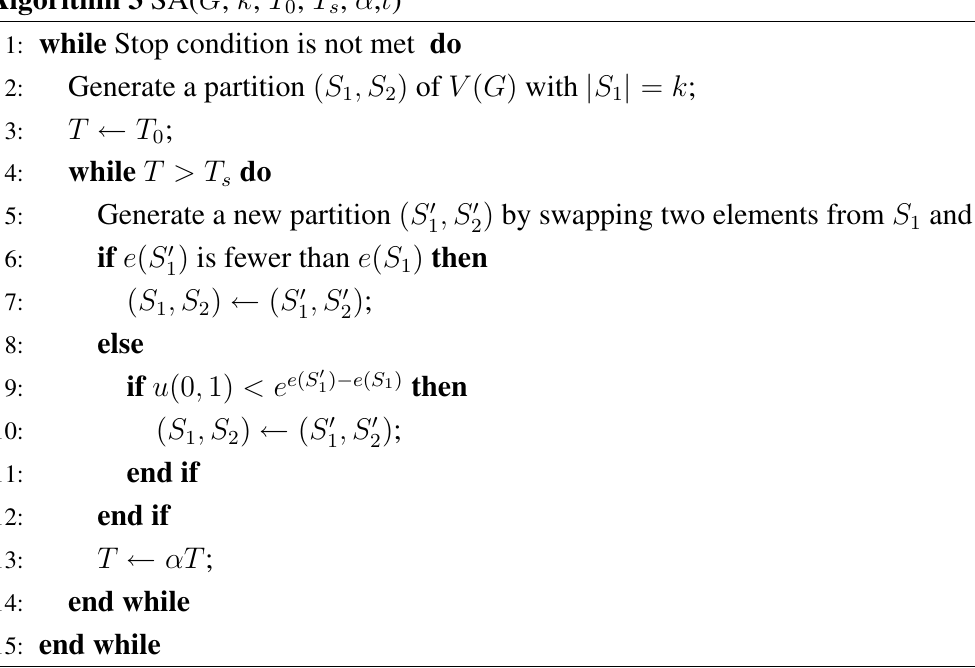
Algorithm 3 SA( G , k , T